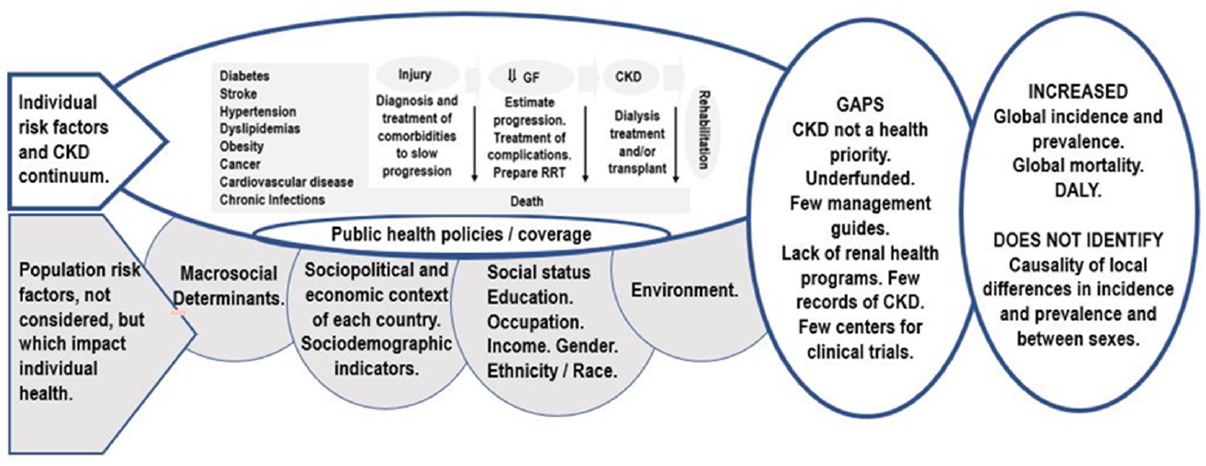
Figure 4. Biomedical model of CKD, which does not include population risk factors. Source: Authors’ own creation.